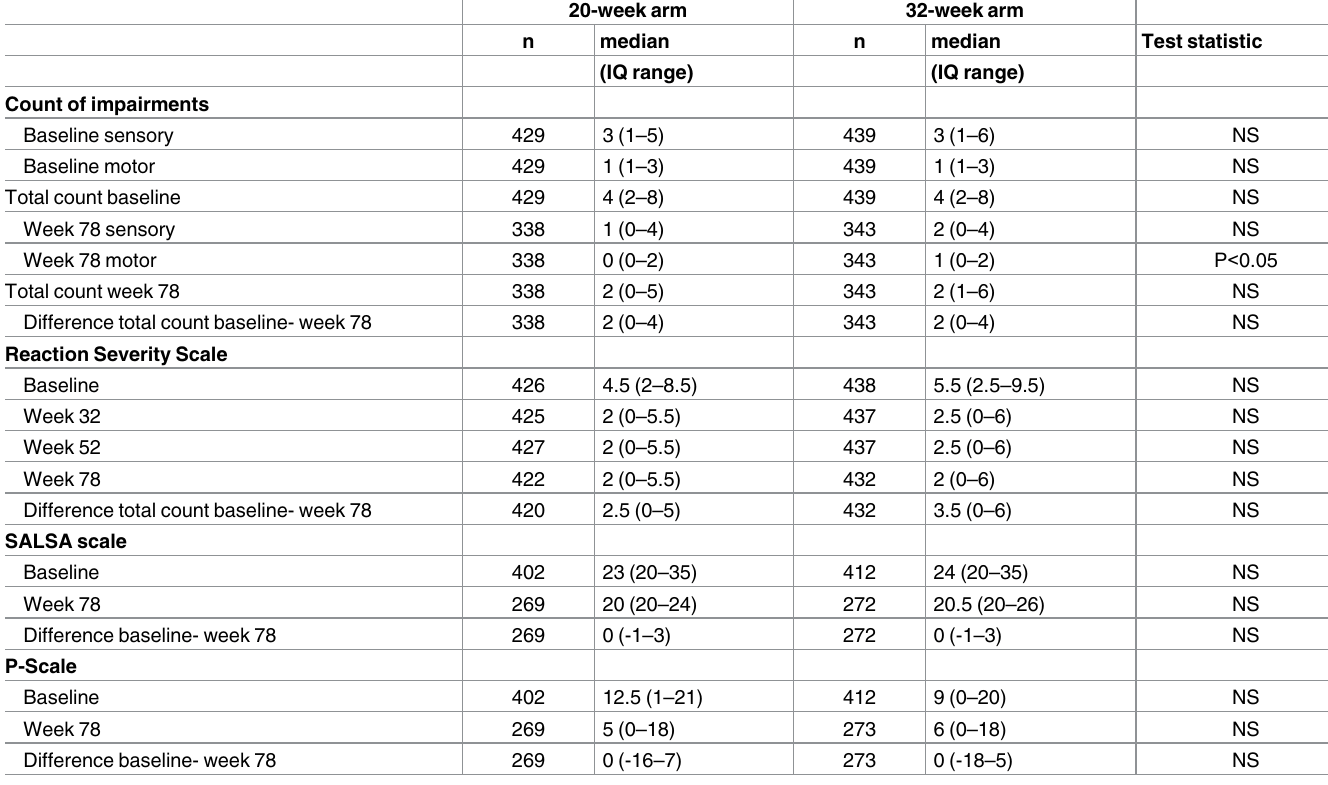
Table 5. Secondary outcomes: impairment, reaction severityscale, SALSA scale,